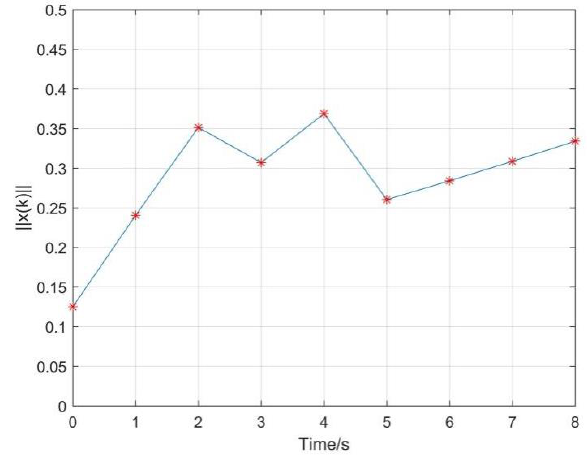
Figure 2. The trajectory of (cid:107) x ( k ) (cid:107) .